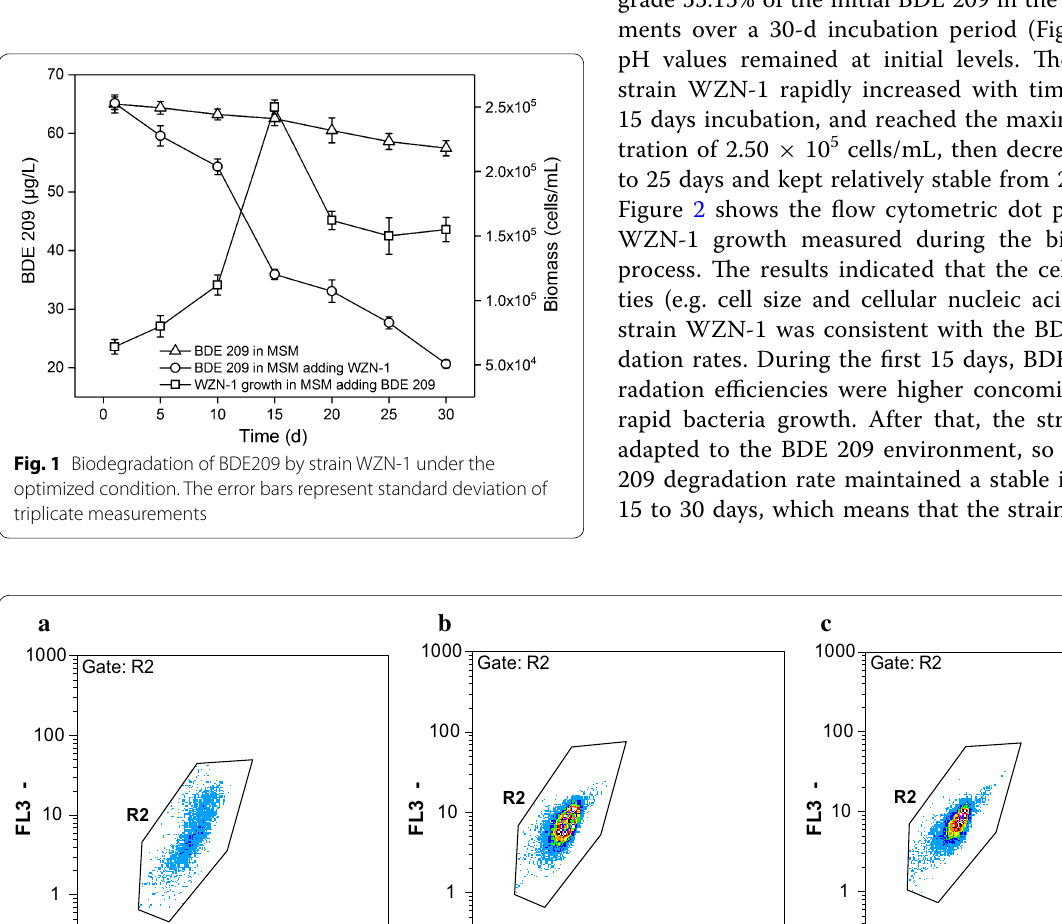
520 20 nm, and FL3 represents the red fluorescence was collected at FL3 = ±